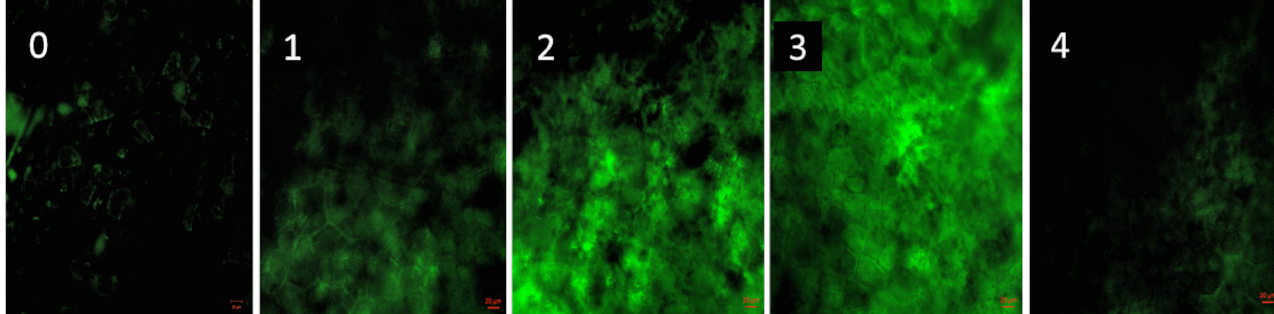
Fig. 4: Confocal laser-scanning fluorescence images of ‘Granny Smith’ apple peel slices. Superficial scald index 0, no scald; 1, 1-25%; 2, 26-50%; 3, 51- 75%; 4, 76-100%.